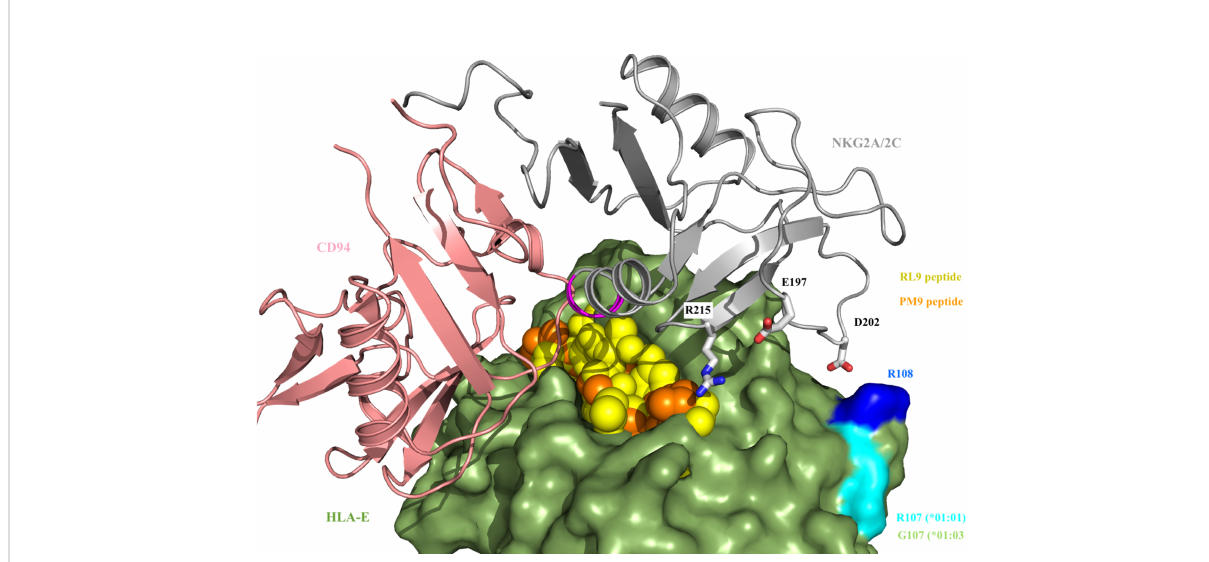
FIGURE 7 CD94-NKG2(A/C) interaction with HLA-E-VL9/PM9 peptide. VL9 (in yellow) and PM9 (in orange) peptides protrude from HLA-E (in green) allowing for an additional interaction with Arg215 from NKG2A/2C (in grey). Residue 197 (Glu residue in NKG2A and Lys residue in NKG2C, respectively) is close to Arg 215. The ASILP and SIISP sequence motifs (in magenta) presented by NKG2A and NKG2C, respectively, are in close proximity to position P5 of VL9 and PM9/RL9 peptide. HLA-E (in green) differs in Arg/Gly 108 (in cyan), which interacts with NKG2A/2C Asp 201 through Arg 108 (in